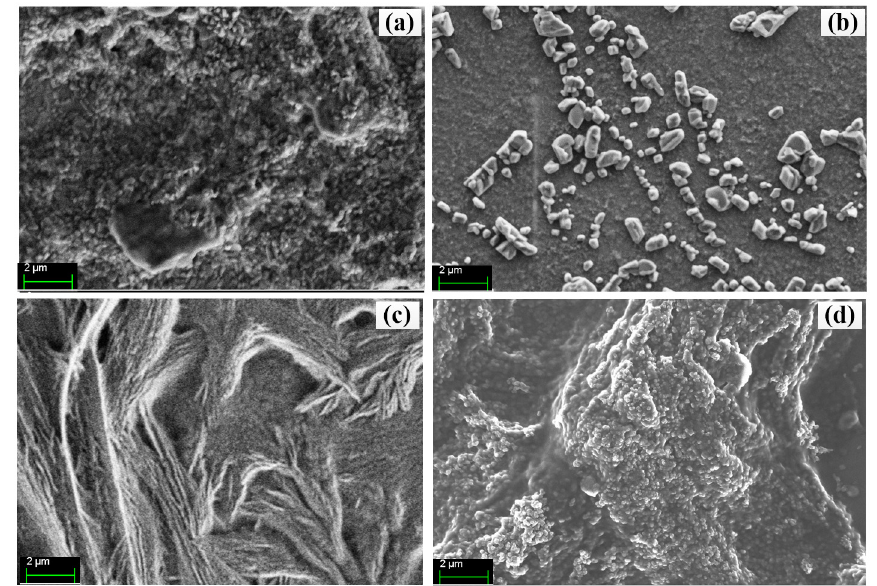
Figure 2. FESEM images of ( a ) PANI, ( b ) PANI/chitosan, ( c ) PANI/RGO and ( d ) Ternary composites processed using NMP.